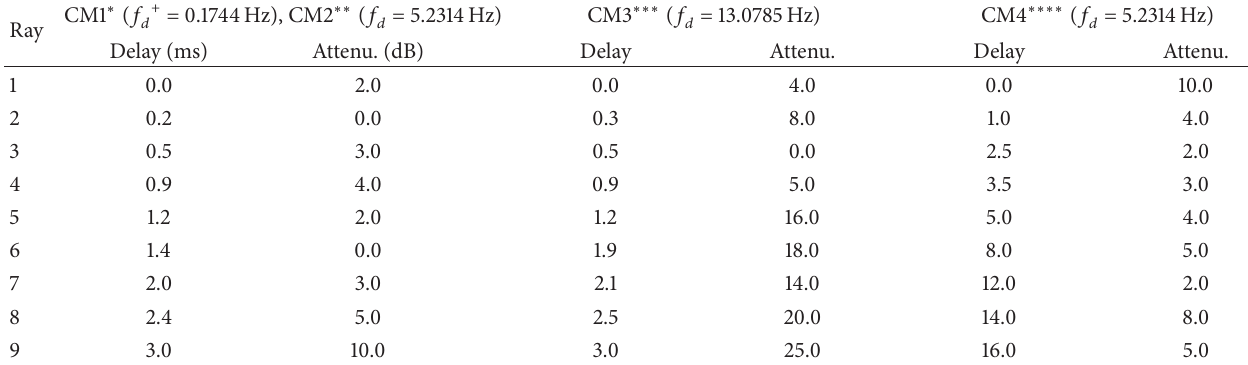
Table 1: FM band channel